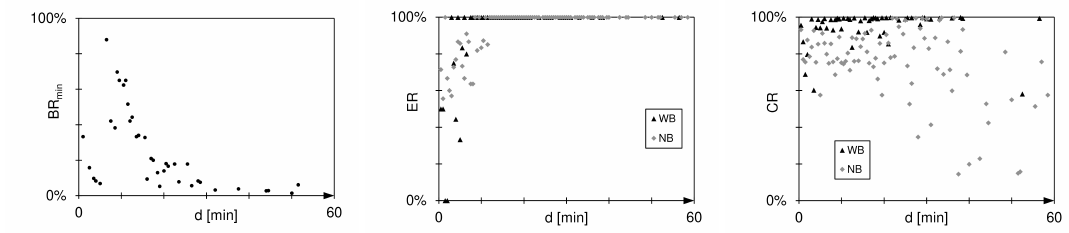
Figure 4. Applicability of a fast turnaround FTA . ( Left ): Break-even rate BR min for a fast turnaround in a base scenario with medium total operating costs. ( Middle ): Success rate ER and ( right ): compensation rate CR